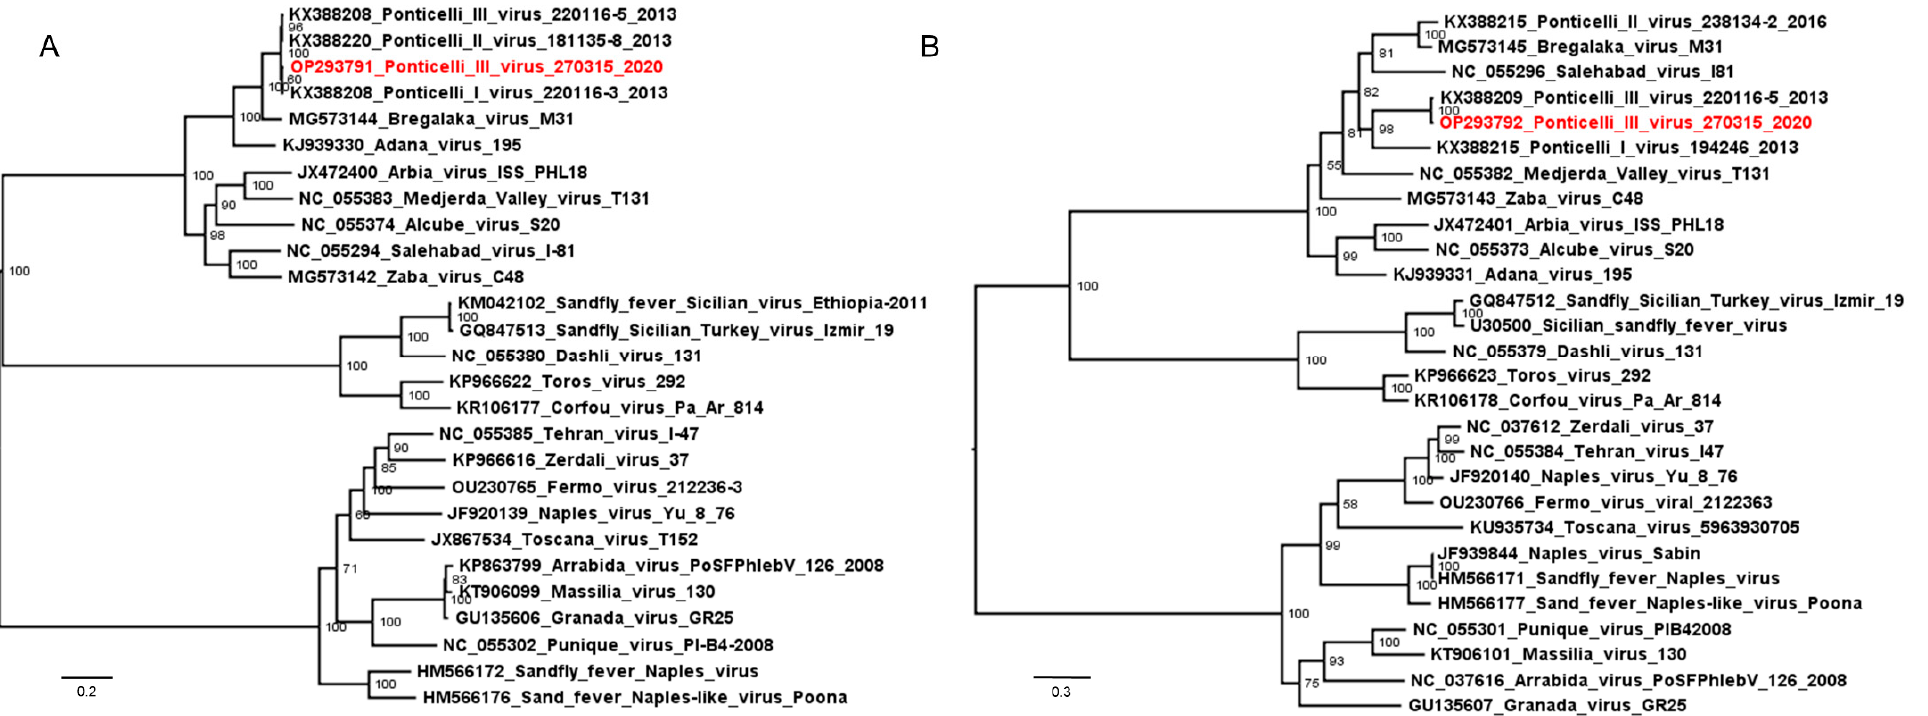
Figure 1. Mid-point rooted ML phylogenetic tree obtained by sequences of L segments ( A ), and M segments ( B ), of the viruses isolated from sandflies in the Mediterranean and Middle East. Virus isolated in this study is shown as red. Bootstrap values are shown near the nodes.